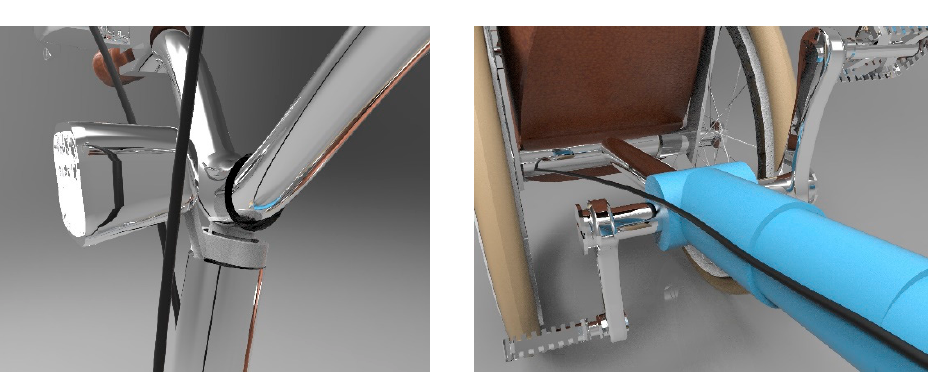
Figure 18. 3D model and rendering.